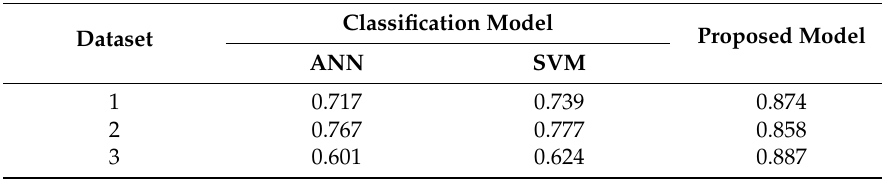
Table 6. The monitoring accuracy of different